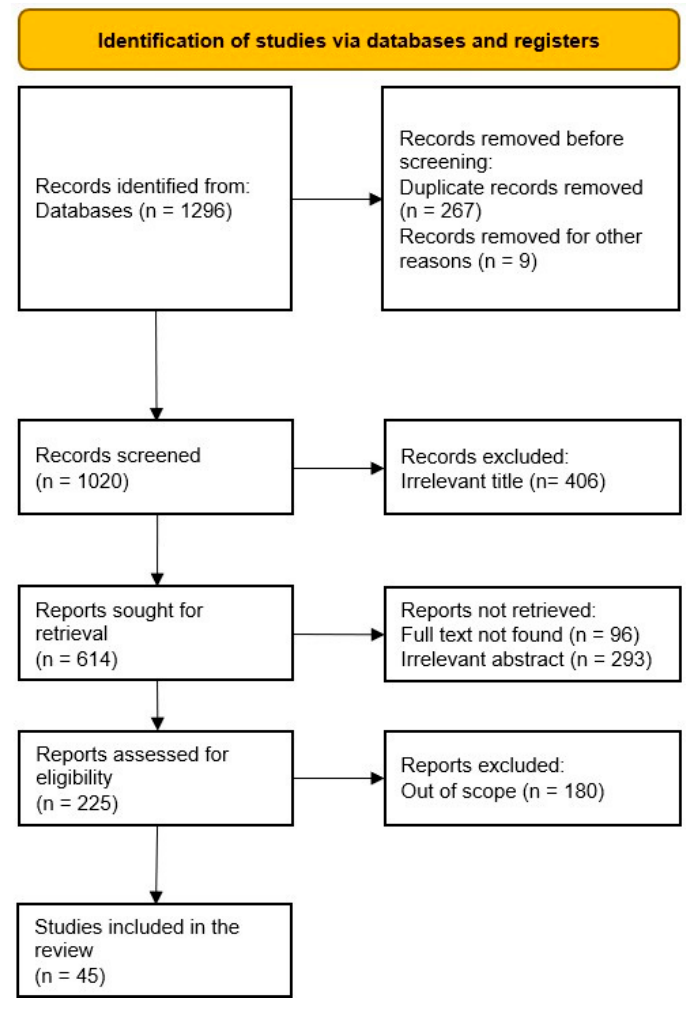
Figure 1. PRISMA flow diagram.